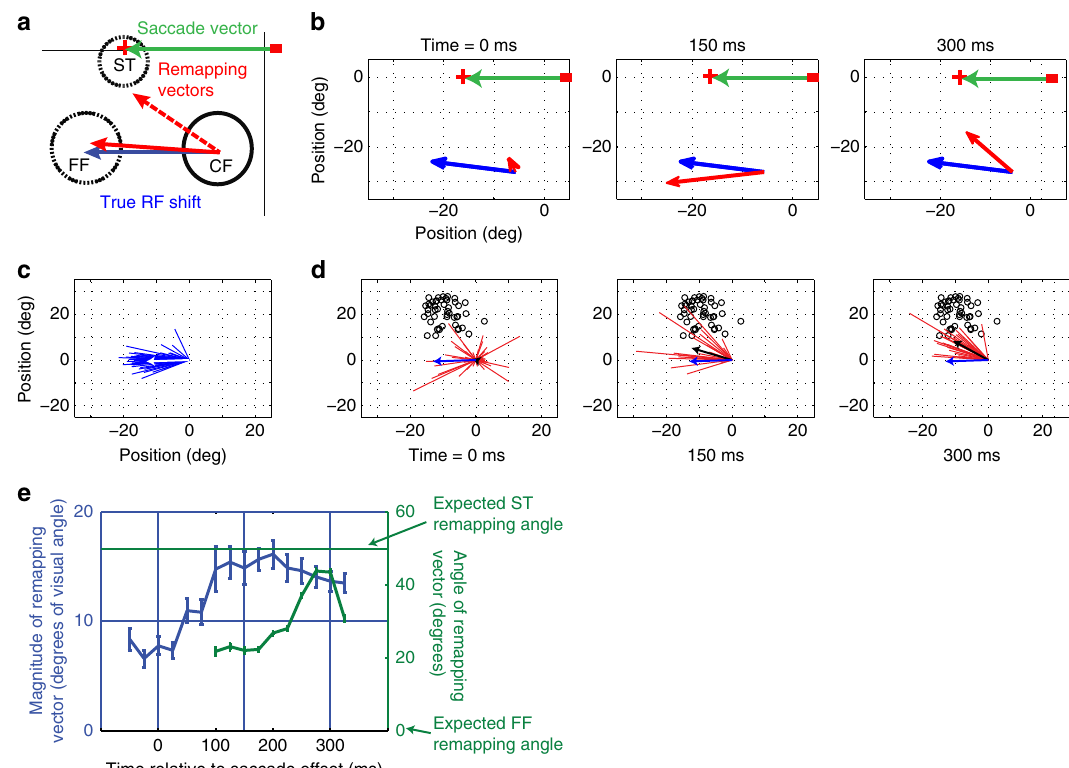
Figure 3 | Quantification of receptive field remapping for towards saccades. ( a ) Receptive field geometry, as in Fig. 2a. ( b ) True RF shift vector (obtained by joining RF centres, 75ms after P1 and P3 onset, respectively) and remapping vector of the example neuron from Fig. 1c at different times relative to the saccade offset. ( c ) True RF shift vectors of the population of 54 neurons. The white arrow indicates the average vector. ( d ) Remapping vectors of the population of cells at different times relative to saccade offset. The black arrows indicate the average vectors. The blue arrow shows the average true RF shift (same as white arrow in ( c )). Since all the RFs are centred at the origin, saccade target positions vary (indicated by small black circles). ( e ) Time course of average magnitude (blue; error bars represent s.e.m. across the population of neurons) and mean direction (green; error bars represent circular s.d.) of the remapping vectors relative to the saccade offset.